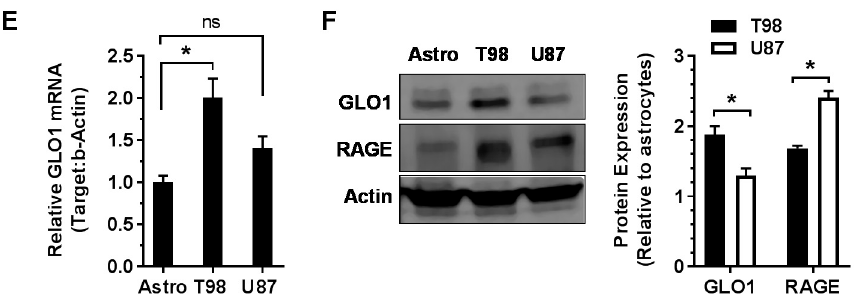
Figure 2. Expression of GLO1 and RAGE in patient GBM tissues and cell lines. ( A ) Immunofluorescence in patient tumor tissue revealed strong GLO1 and RAGE protein expression (green). GFAP staining (red) indicates tumors of glial origin. Nuclei were stained with DAPI (blue); ( B ) Orthogonal view through a confocal Z -stack of patient GBM tumor tissue reveals cytoplasmic (c) localization of GLO1 (green) and GFAP (red). Nuclei (n) were stained with DAPI (blue); ( C ) Confocal Z -stack analysis of RAGE (green) in patient GBM tissue revealed both cytoplasmic (c) and nuclear/perinuclear (n) localization; ( D ) Immunocytochemistry of T98 and U87 GBM cells revealed co-expression of GLO1 (green) and RAGE (red) protein. Nuclei were stained with DAPI (blue). Scale bars represent 40 µ m; ( E ) GLO1 mRNA expression levels in T98 and U87 GBM cells were determined by RT-qPCR, normalized to β -actin and compared to astrocyte controls; ( F ) Western blot analysis and quantification revealed GLO1 and RAGE protein levels in T98 and U87 cells relative to astrocytes; * p < 0.05, ns = not significant by Student’s t -test.